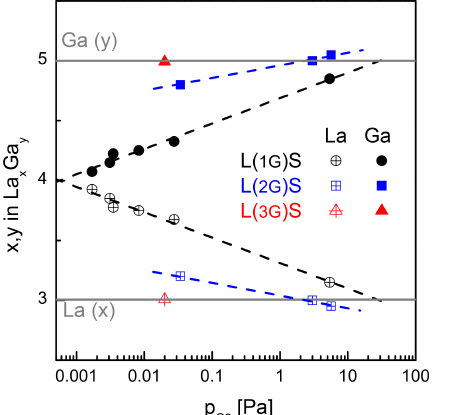
Figure 2. Ga and La content determined by SNMS as function of the oxygen partial pressure during deposition. The count rate is cal- ibrated by the use of the stoichiometric LGS single-crystalline sub- strates as standards. The films are grown at the substrate temper- ature of 600 ◦ C (L(1G)S, (L(2G)S) and 450 ◦ C (L(3G)S), respec-